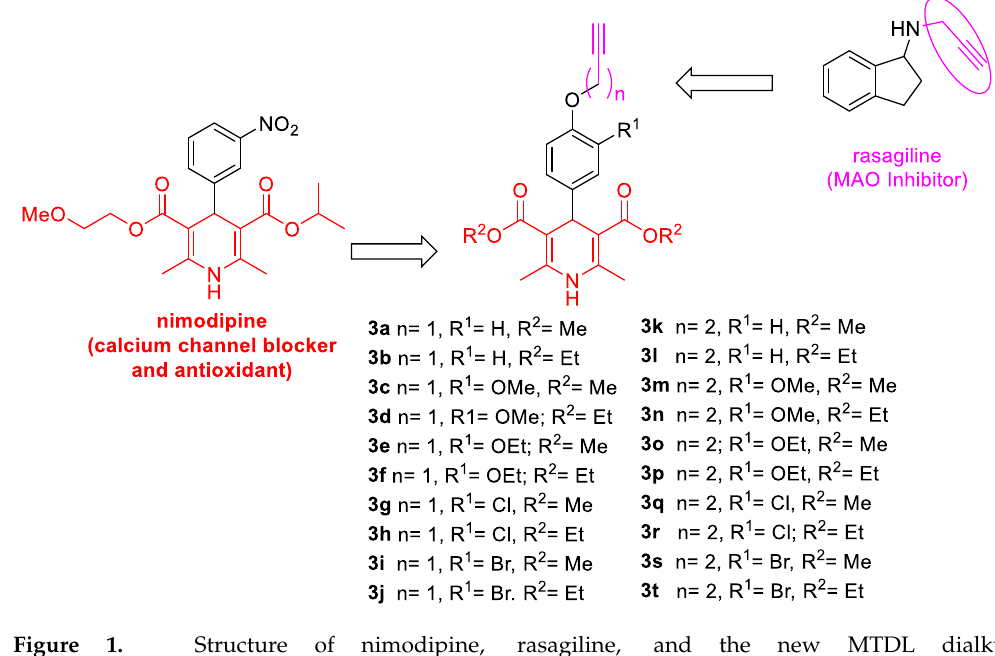
Figure 1. Structure of nimodipine, rasagiline, and the new MTDL dialkyl 2,6-dimethyl-4-(4-(prop-2-yn-1-yloxy)phenyl)-1,4-dihydropyridine-3,5-dicarboxylate derivatives 3a – t reported here.